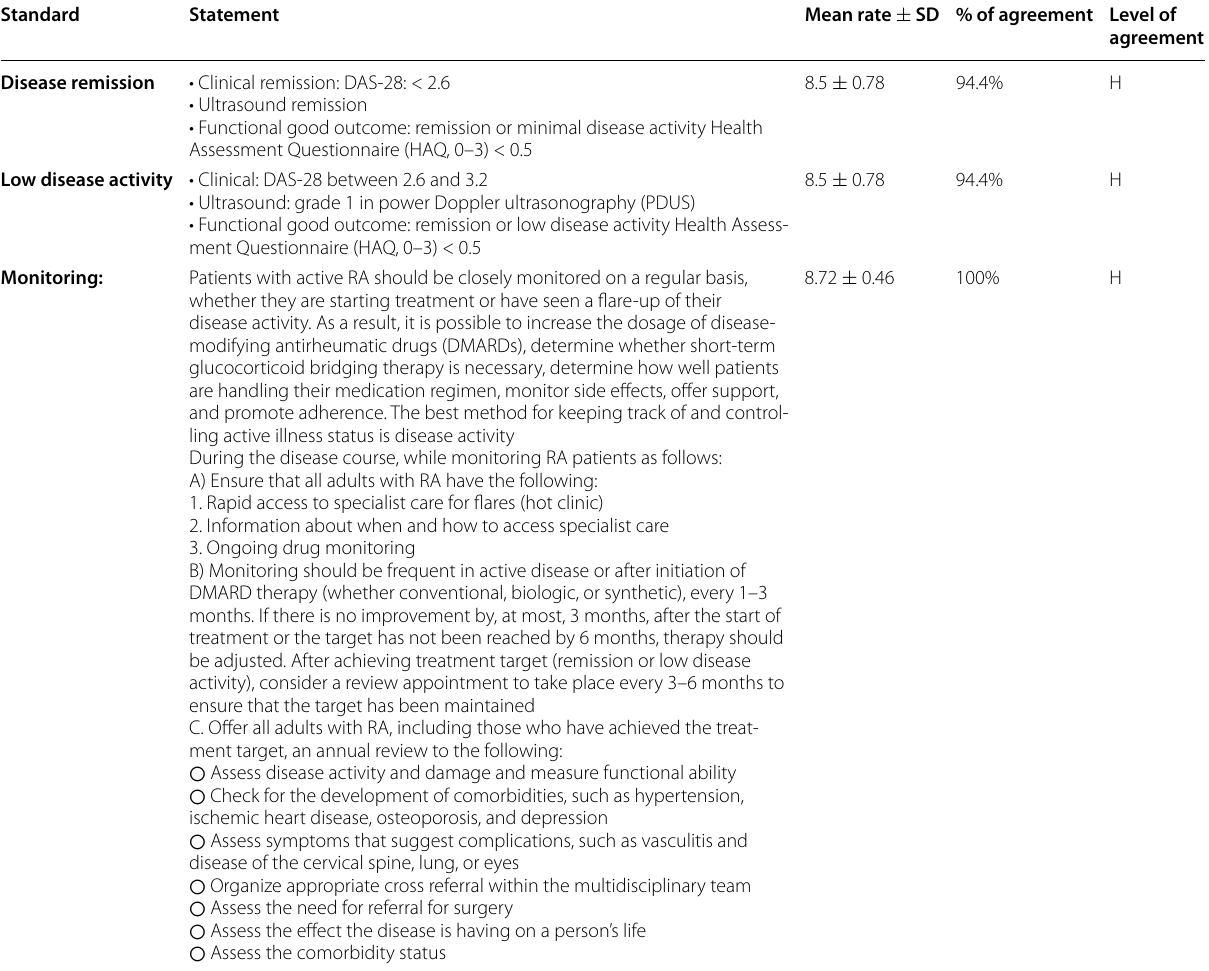
Table 3 Disease monitoring and remission parameters